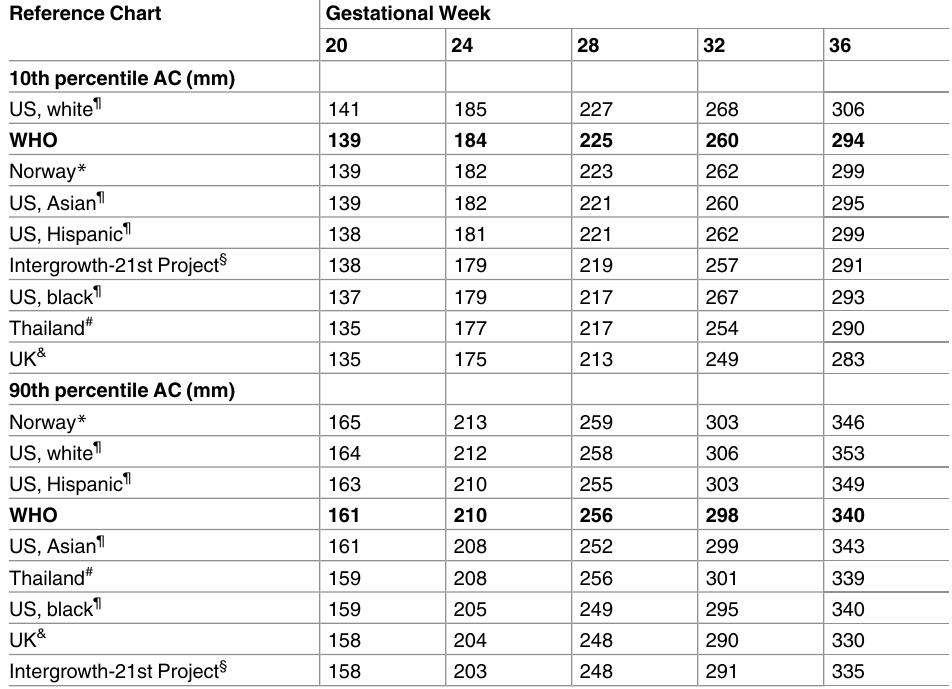
Table 17. The 10th and 90th percentile for fetal abdominal circumference in relation to relevant refer- ence values. Reference Chart Gestational Week